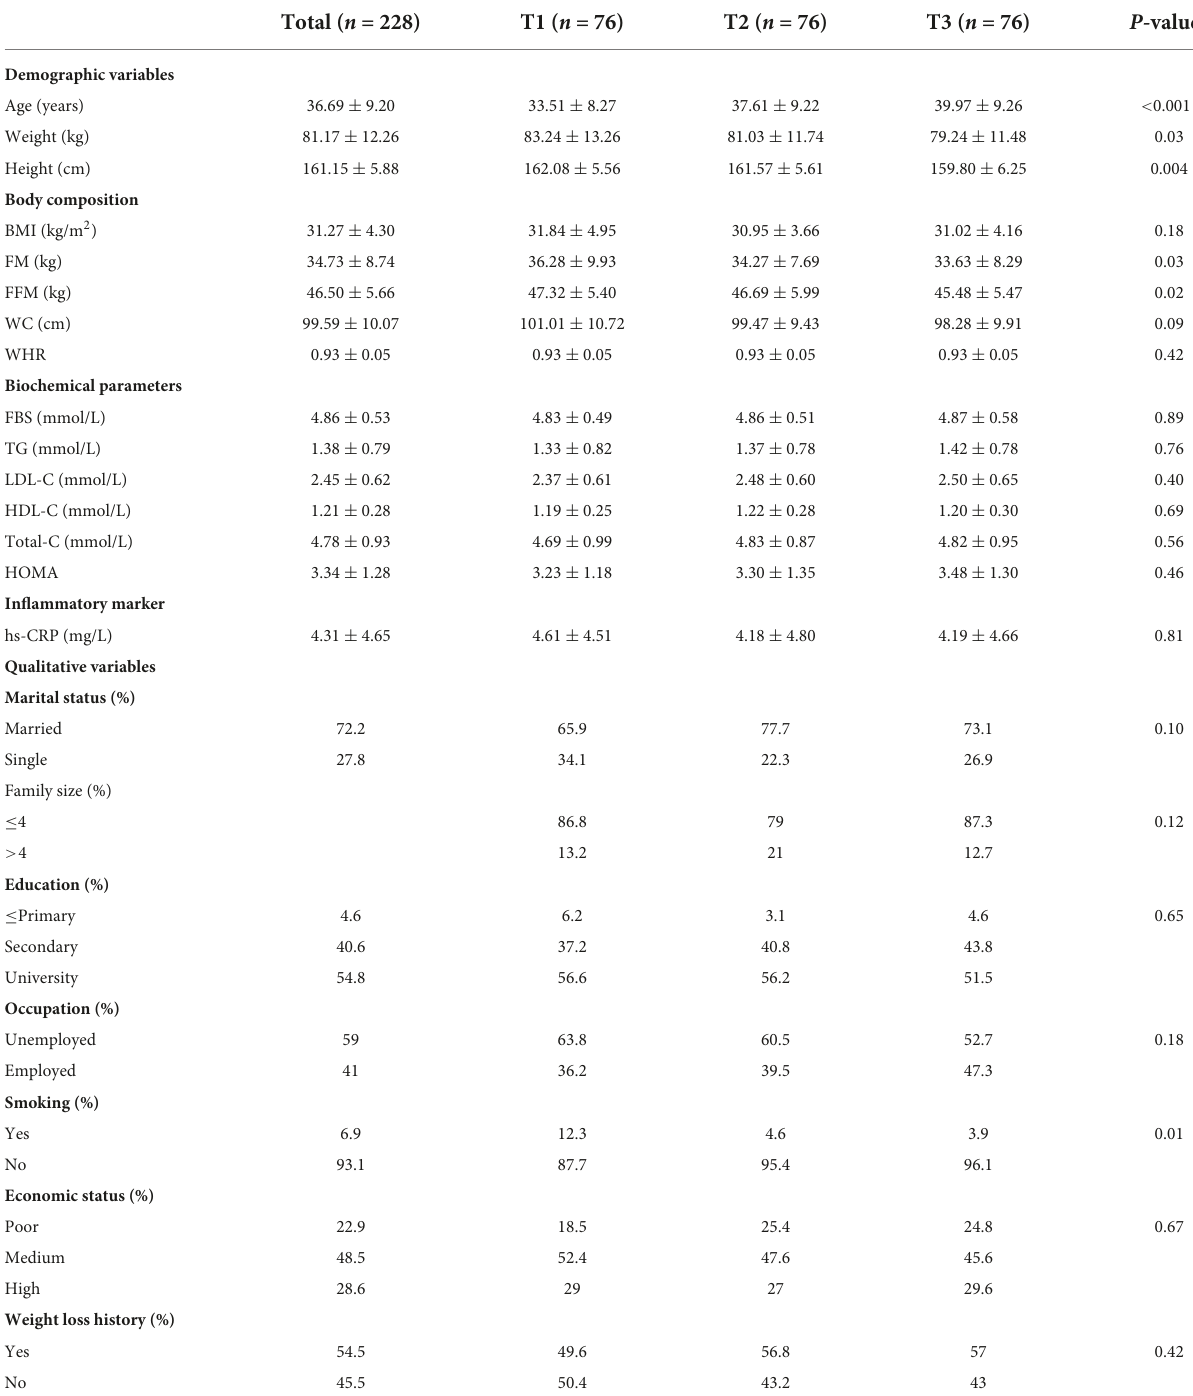
TABLE 1 General characteristics of study participants by tertiles of